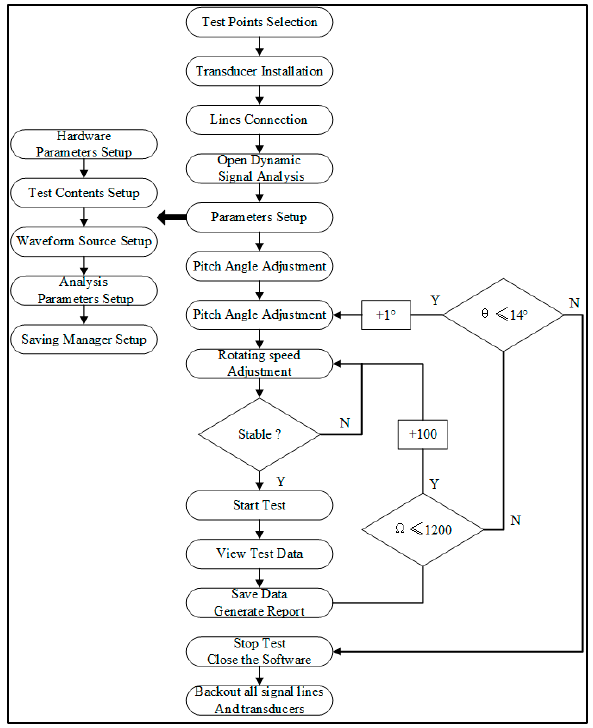
Figure 4. Vibration measurement flow diagram.